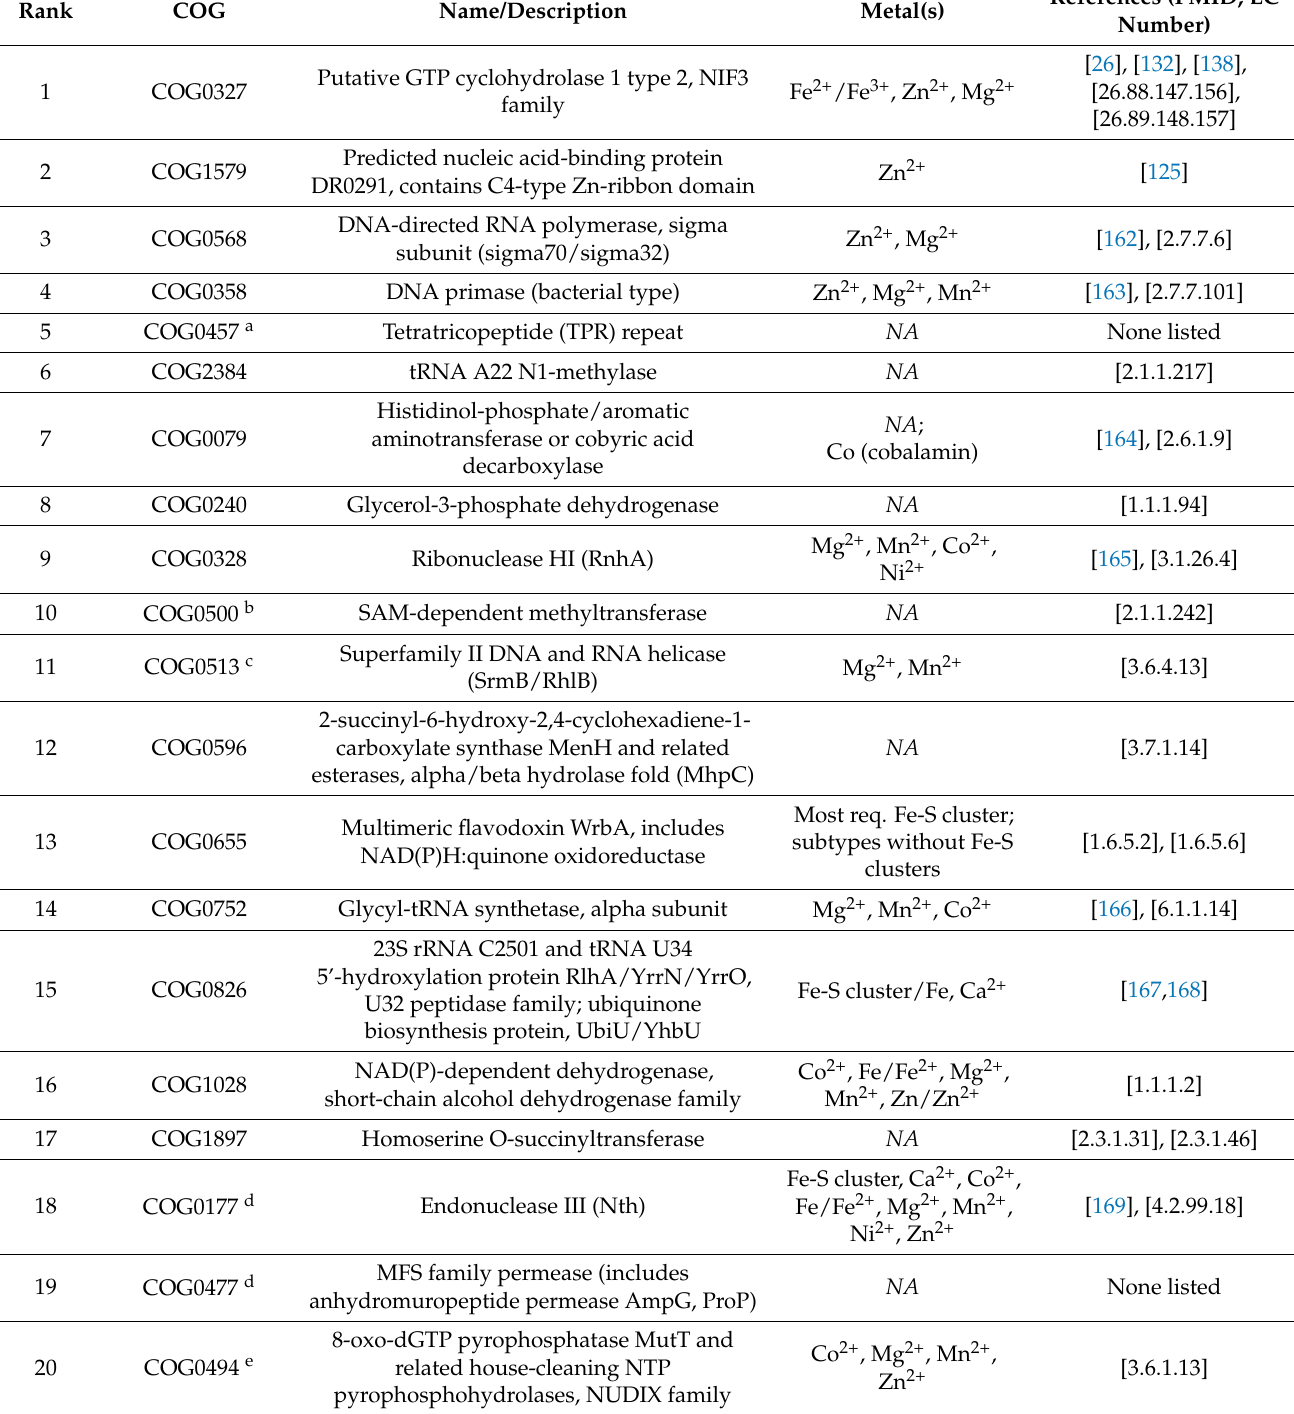
Table 3. Top 20 COGs found to occur in operons containing